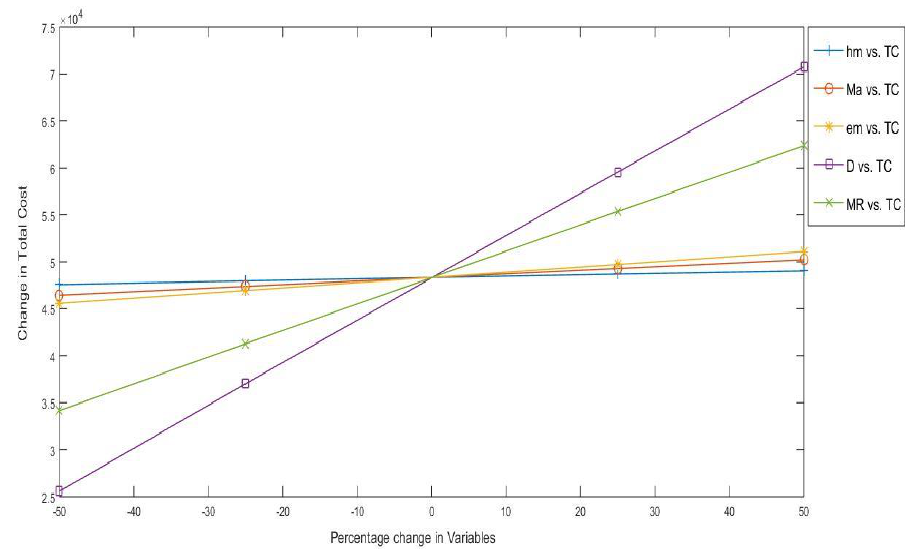
Figure 3. Graphical representation of sensitivity analysis .